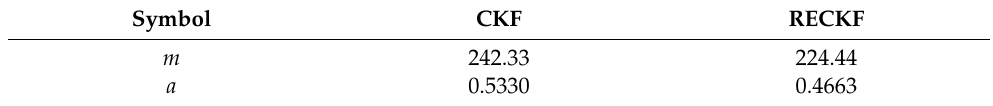
Table 5. The RMSE in the case of